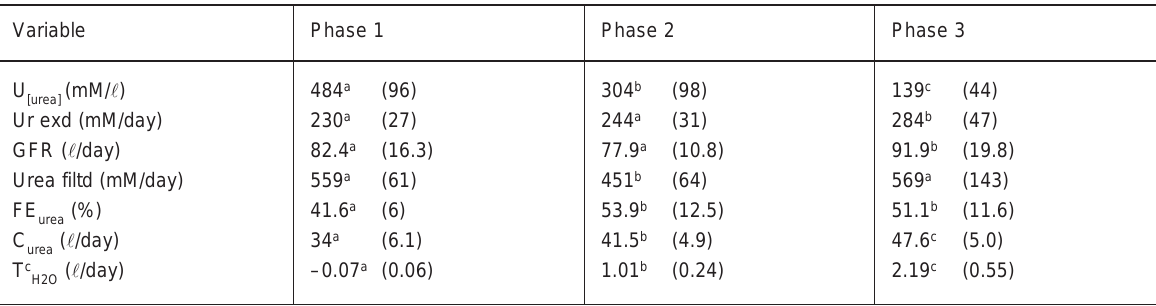
), urea excreted daily via the urine (Ur exd), glomerular filtration rate (GFR), urea filtered TABLE 3 Urine urea concentrations (U [urea] (urea filtd), fractional excretion of urea (FE ), plasma clearance of urea (C ) and electrolyte-free water reabsorbed urea urea (T c ) for sheep on fresh water (phase 1), half isotonic saline (phase 2) and isotonic saline (phase 3). Mean values (SD); H2O n = 6 are